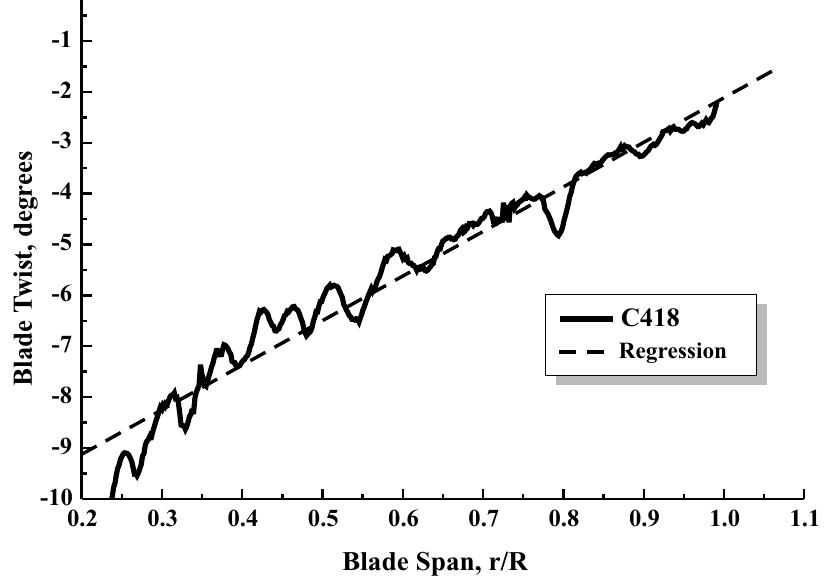
Fig. 16. Spanwise blade twist distribution, blade #4, Ψ = 90 ◦ . Regression slope = 0.0102 deg./mm. and deflected greater with respect to the hinge. In each case, the rotor blade is shown to be deflecting linearly along the spanwise direction, indicating little flapwise bending other than the steady-state coning